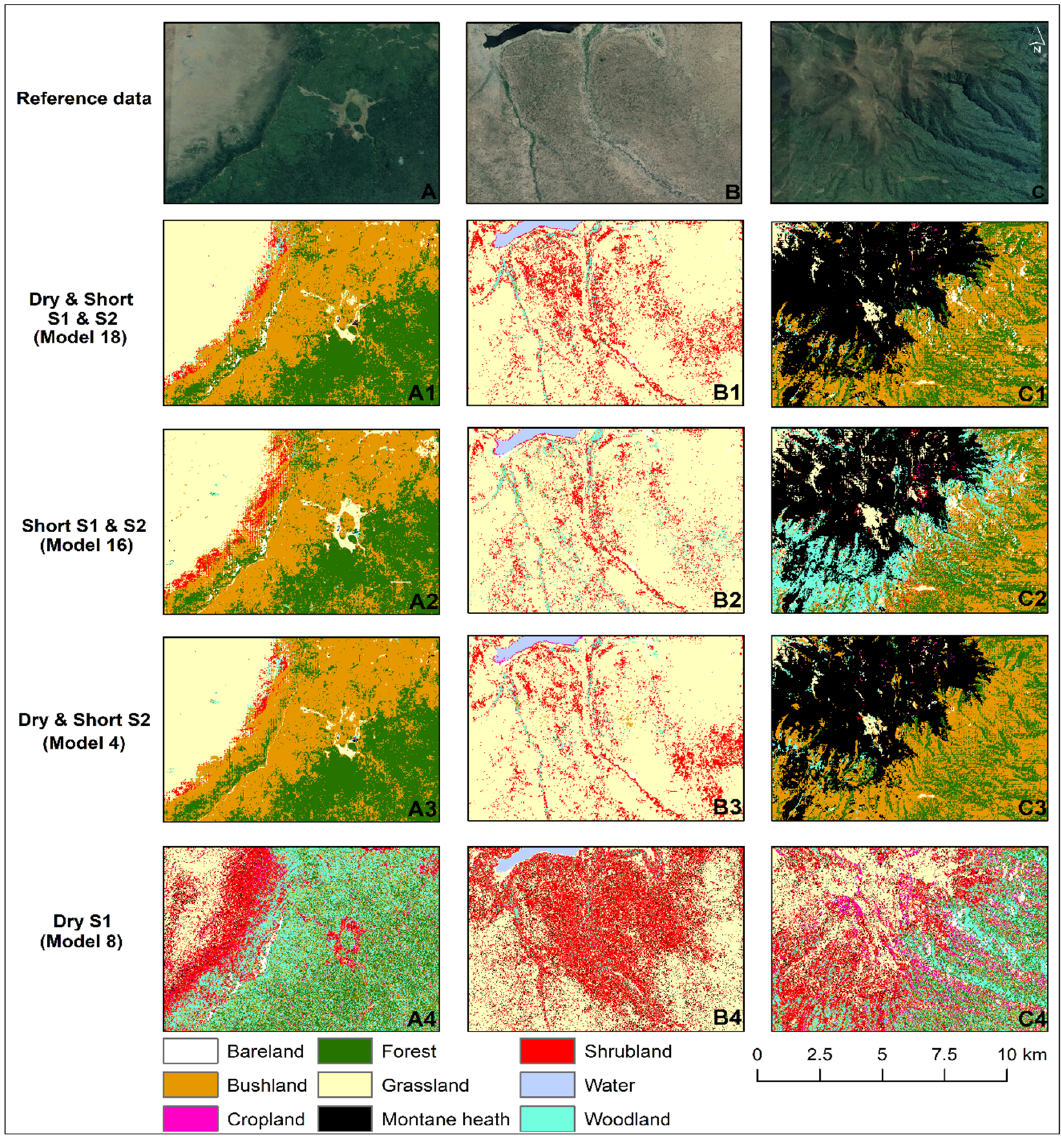
Figure 7. Example subsets of the study area: ( A – C ): very-high resolution imagery; ( A1 – C1 ): land cover maps from Model 18; ( A2 – C2 ): land cover maps from Model 16; ( A3 – C3 ): land cover maps from Model 4; ( A4 – C4 ): land cover maps from Model 8. Coding of model combinations in Table 2.